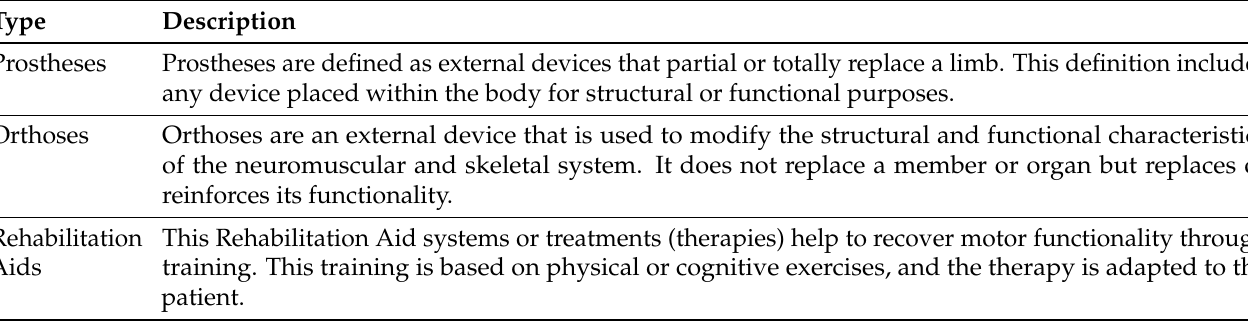
Table 5. Classification of therapeutic robots according to how it is